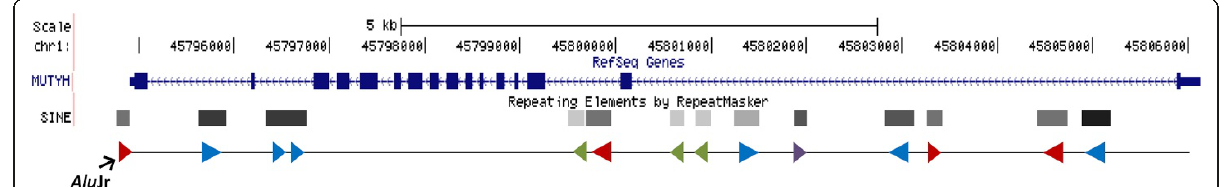
Figure 3 Short interspersed nucleotide element (SINE) content of the MUTYH genomic region (chr1:45794343-45806142) (data from UCSC database and RepeatMasker) . A region of 11.8 kb is shown, extending 571 bp downstream of the MUTYH gene. Vertical bars in the genomic sequence indicate exons. The direction of the arrowheads denotes the orientation of the SINE repeat elements and each family is represented by a different color (Red: Alu J, Blue: Alu S, Green: MIR, Purple: FLAM_C). The black arrow indicates the Alu Jr element involved in the distal breakpoint; no repetitive element is present on the proximal